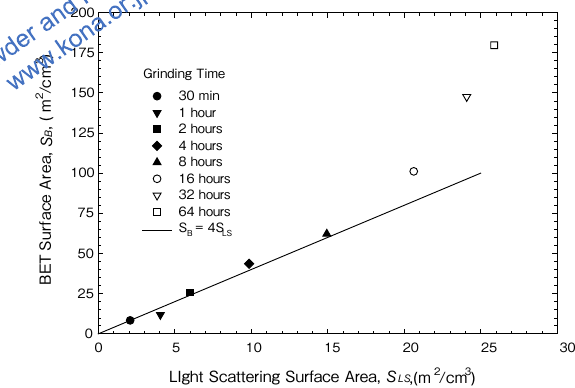
Fig. 3 Correlation between specific surface areas of ground quartz mea- sured by BET gas adsorption and laser